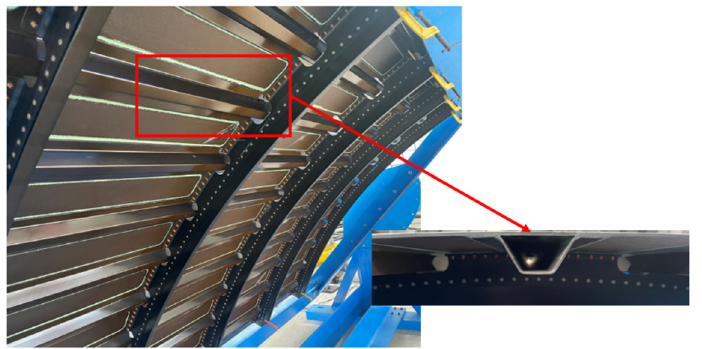
Figure 1. Hat-stringer-stiffened composite panels from the fuselage of an aircraft.